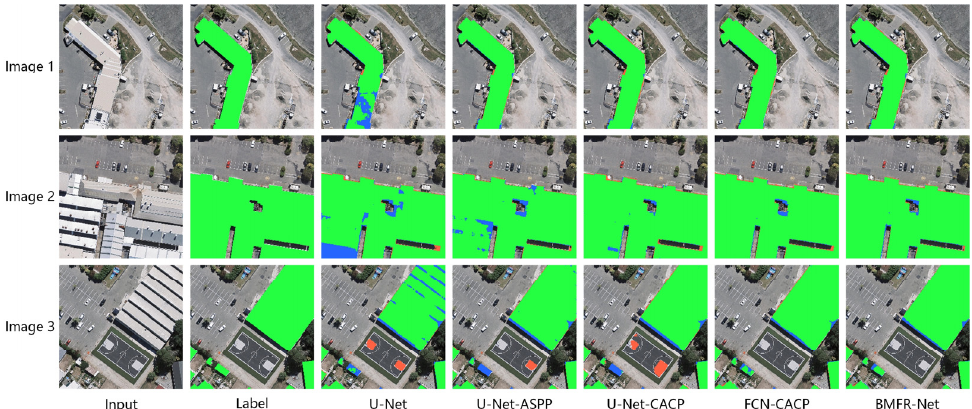
Figure 15. Typical building extraction results of U-Net with different multiscale feature extractions and fusion modules. In the graph, green represents TP, red represents FP, and blue represents FN. According to the results listed in Table 4 and Figure 15: